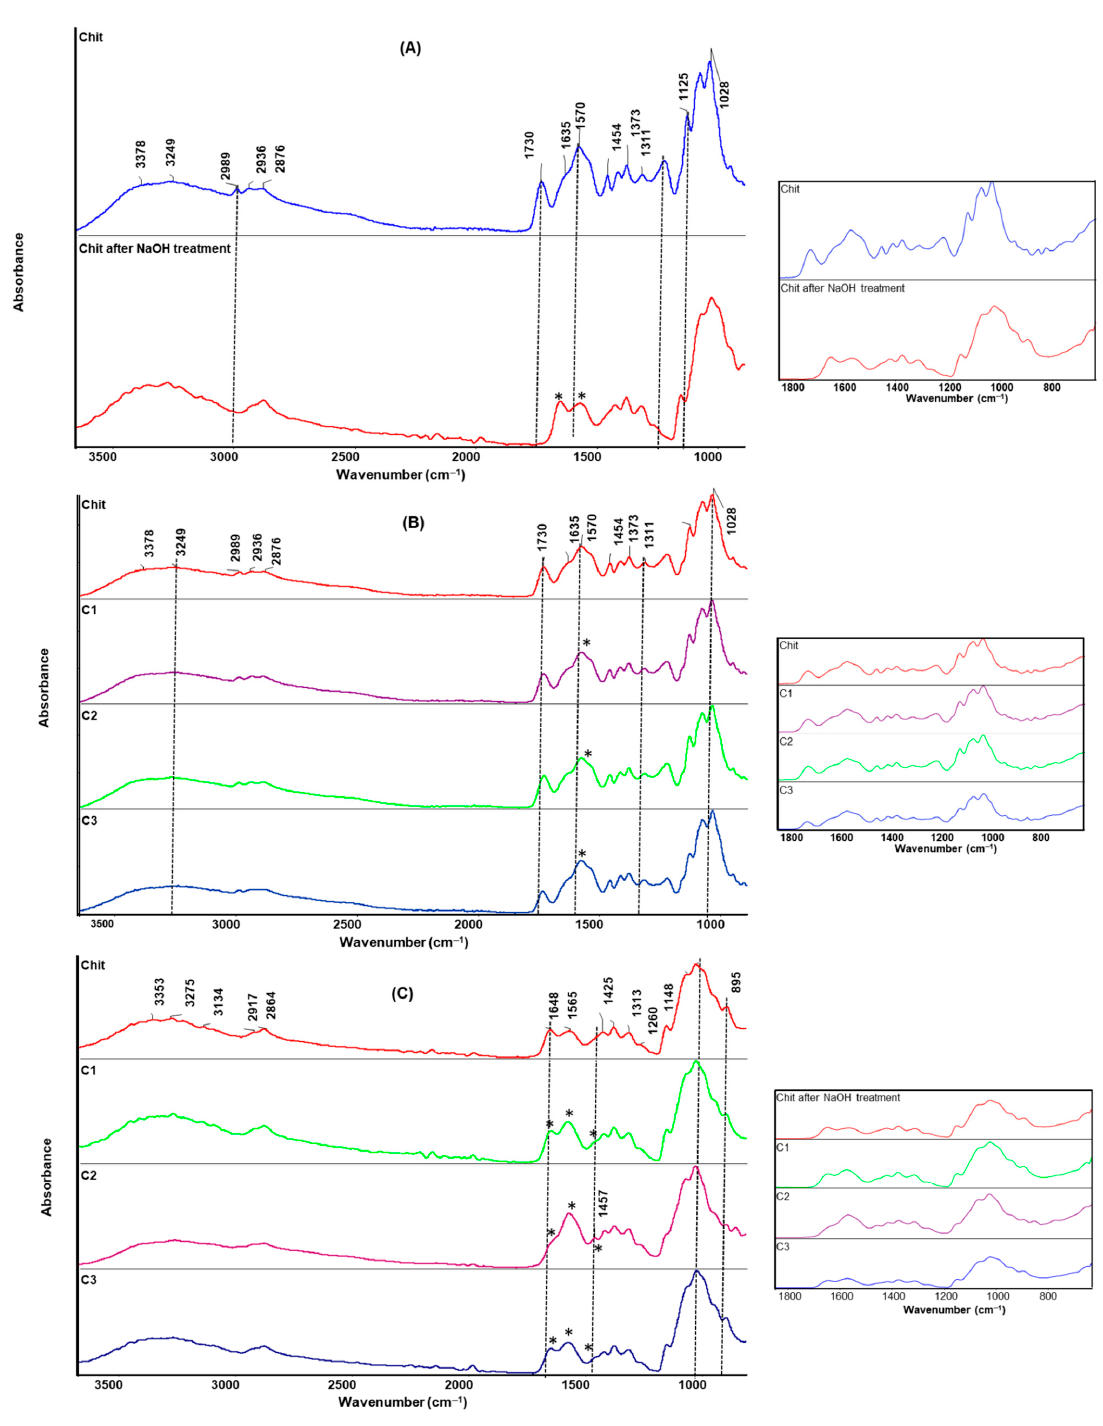
Figure 6. ATR infrared spectra of ( A ) Chit and Chit composite films ( B ) before and ( C ) after NaOH treatment. The inserts are magnification, showing the region of 600–1800 cm − 1 , asterisks (*) indicate changes in the characteristic bands.